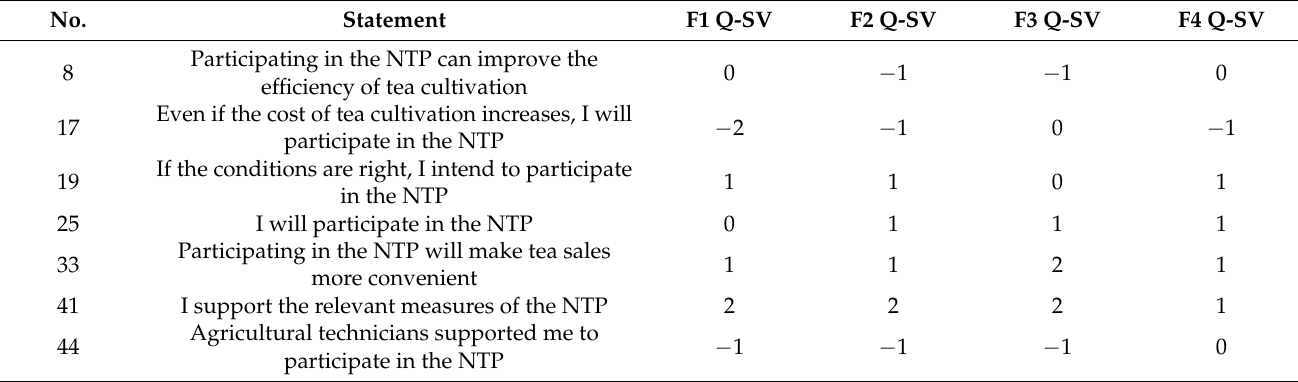
Table 3. Consensus statements across all factors (Q-Sort Value).